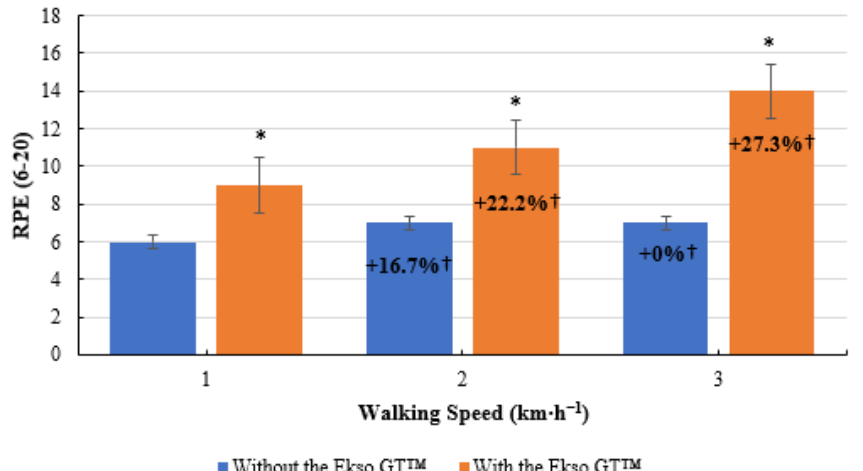
Figure 7. Rate of perceived exertion (RPE) scores during treadmill walking with and without Ekso GT™. * Significantly greater ( p ≤ 0.05) when walking with Ekso GT™ versus walking with Ekso GT™. † Mean percentage RPE increase at each walking phase with and without Ekso GT™.